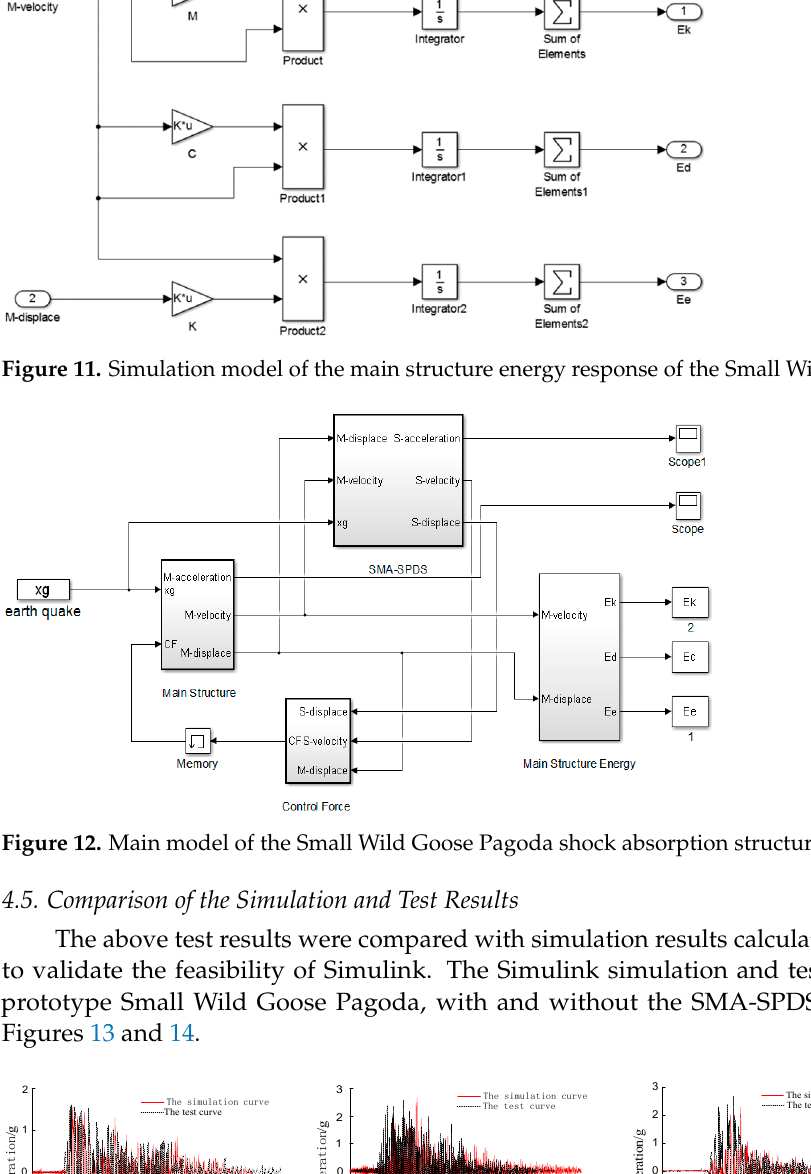
11 of 21 Figure 10. SMA-SPDS simulation model. 4.3. Energy Response Simulation Model When the structure of the prototype Small Wild Goose Pagoda with the SMA-SPDS undergoes earthquakes, most of the seismic energy is dissipated by the damping system. Therefore, the energy dissipation capacity of the damping system directly affects the seis- mic resistance and performance of the Pagoda structure. By integrating and organizing the absolute displacement of the motion equation (For- mula (4)) of the small goose tower structure with SMA-SPDS, the energy balance equation can be simplified as Formula (6): (cid:1831)((cid:1872)) = (cid:1831) (cid:3038) ((cid:1872)) + (cid:1831) (cid:3030) ((cid:1872)) + (cid:1831) (cid:3032) ((cid:1872)) + (cid:1831) (cid:3031) ((cid:1872))